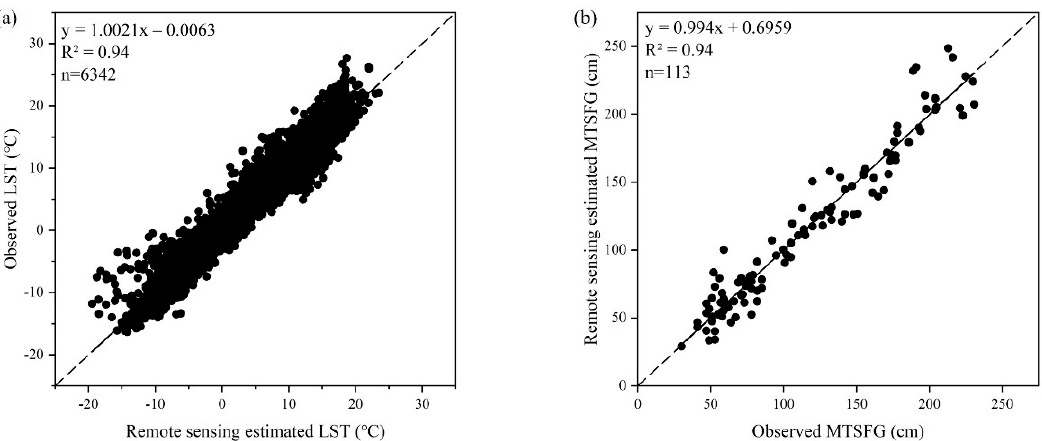
Figure 3. Variables estimated by remote sensing against the observations at nine meteorological stations: ( a ) the mean daily LST, ( b ) the MTSFG.